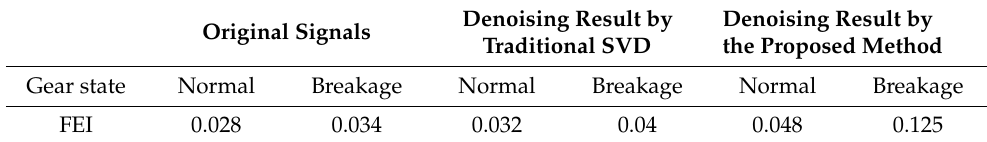
Table 2. The comparison of FEI with different processing method.